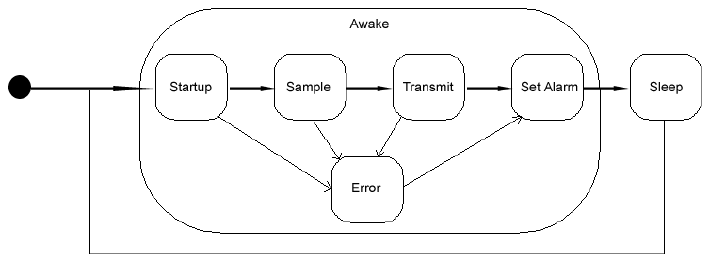
Figure 4. SEMAT Buoy States.